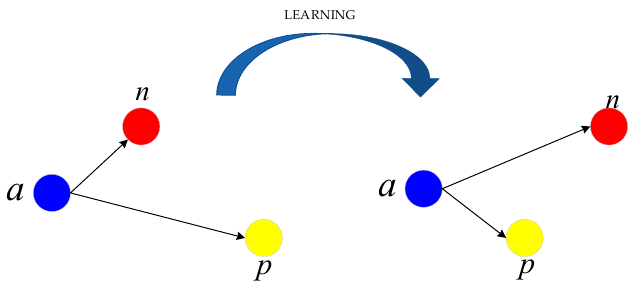
Figure 4. Triplet loss guides model learning with more discriminative features during the training process.